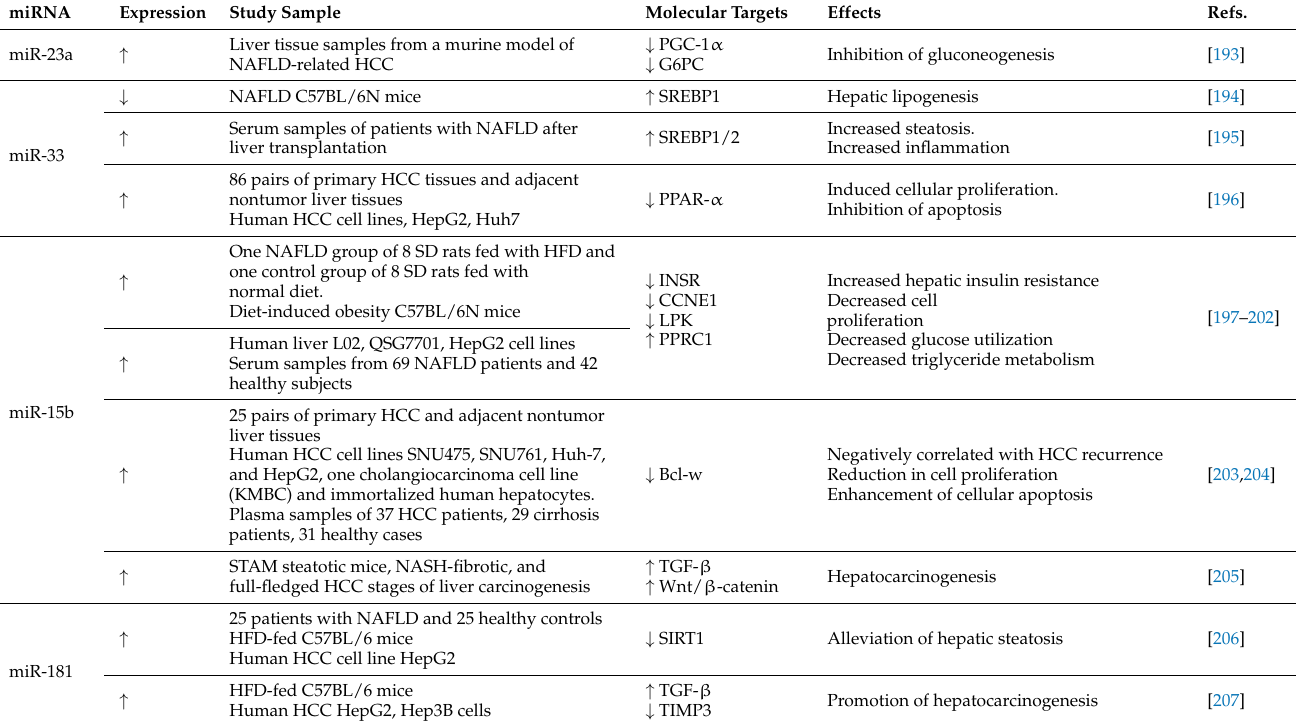
Table 1. Other dysregulated miRNAs involved in both NAFLD and HCC. Molecular Targets Effects